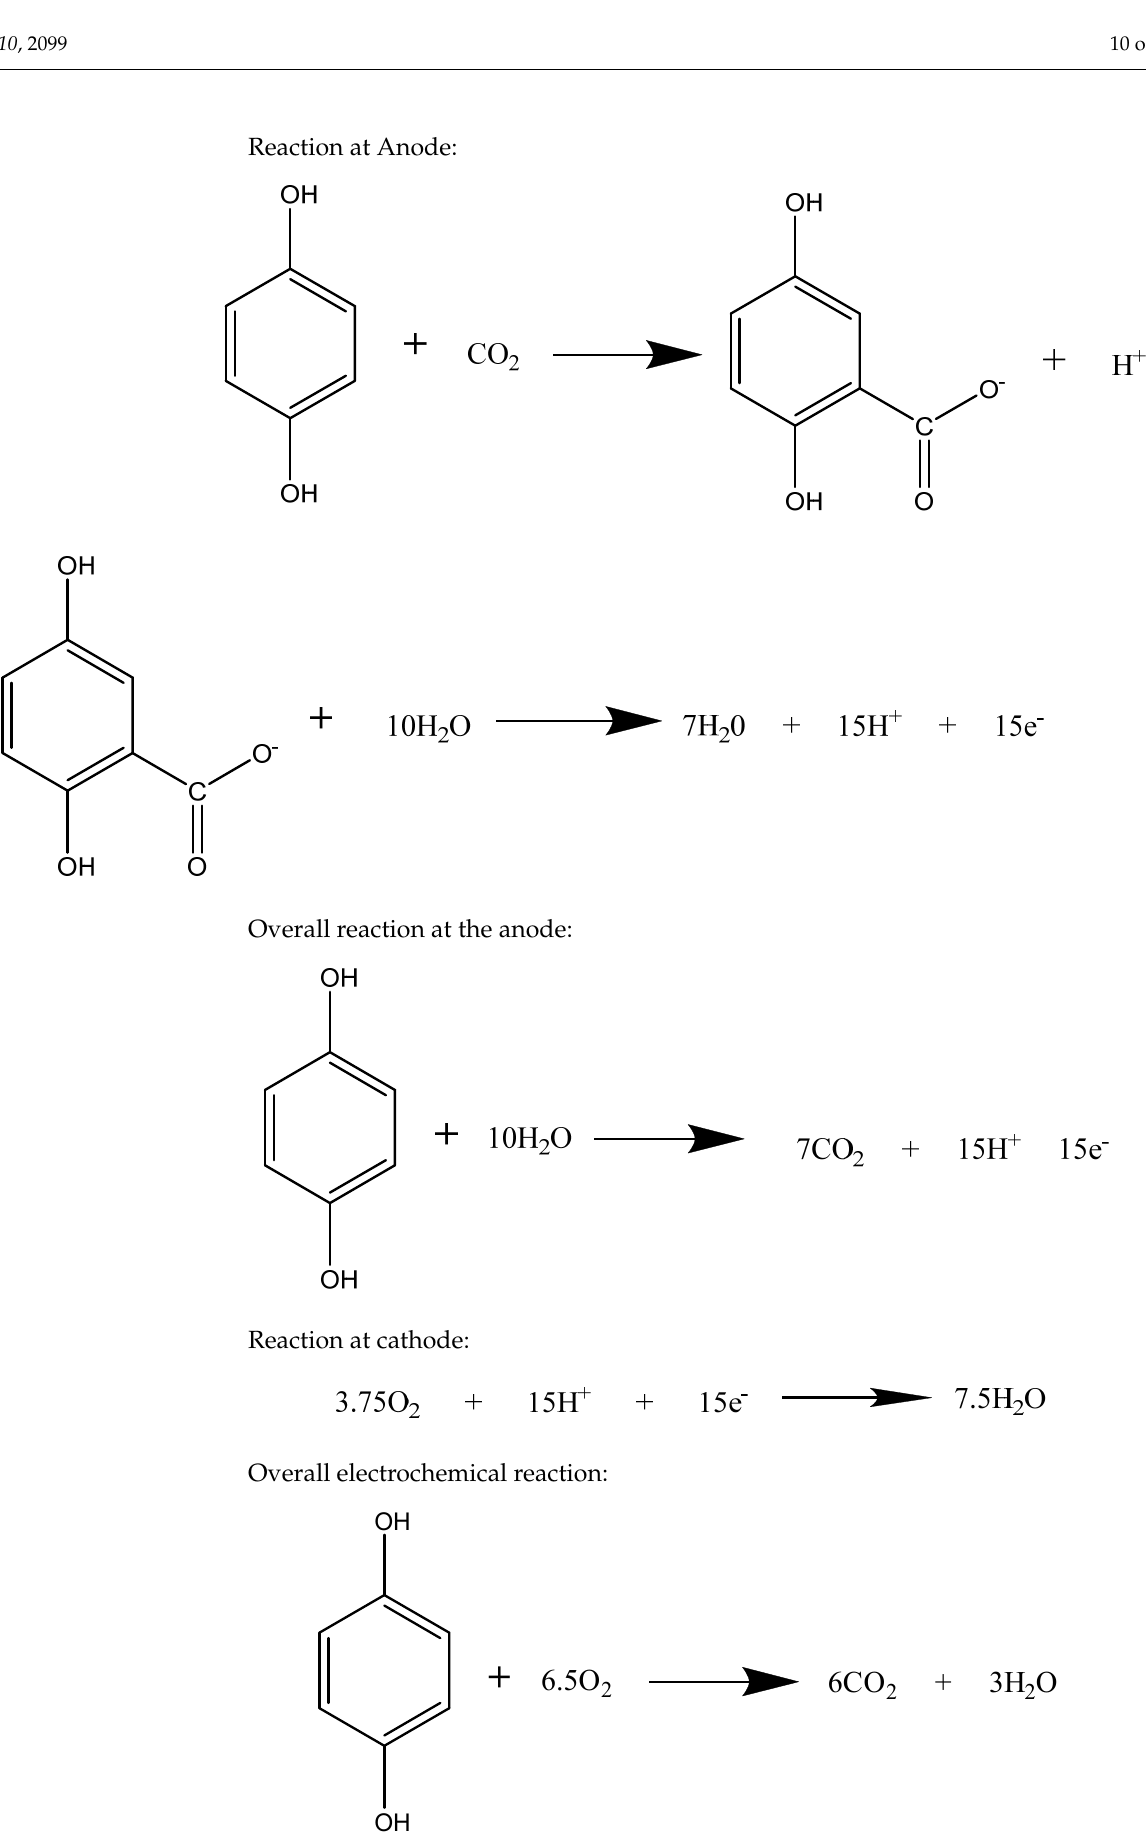
Figure 5. Microbial degradation of hydroquinone in a single -chamber MFC (Idea and figure modified according to the present study from reference [43] with Elsevier